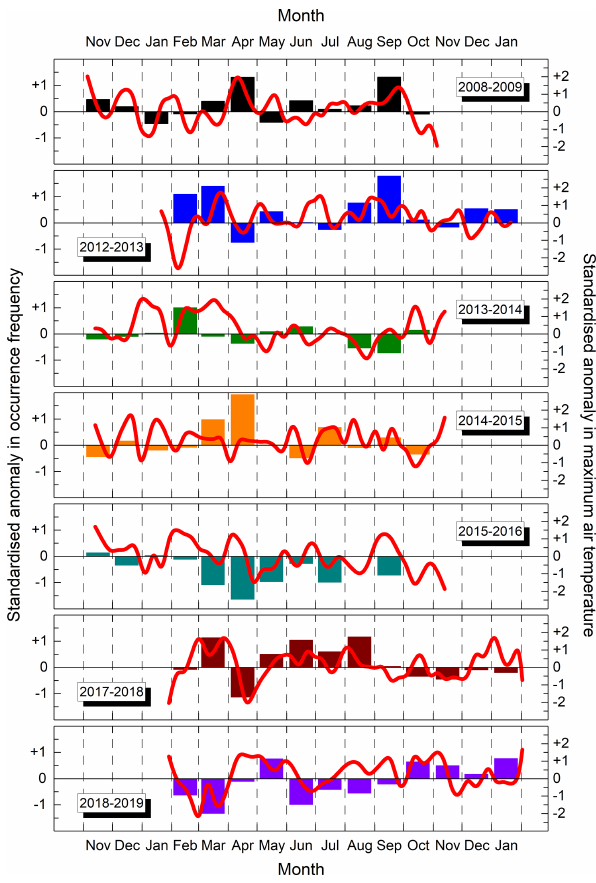
Figure 6. Time distribution of anomalies standardised to the annual SD of the variable in maximum air temperature above vegetated territories (red lines) and in the monthly mean NPF occurrence fre- quency (column charts) for the 7 measurement